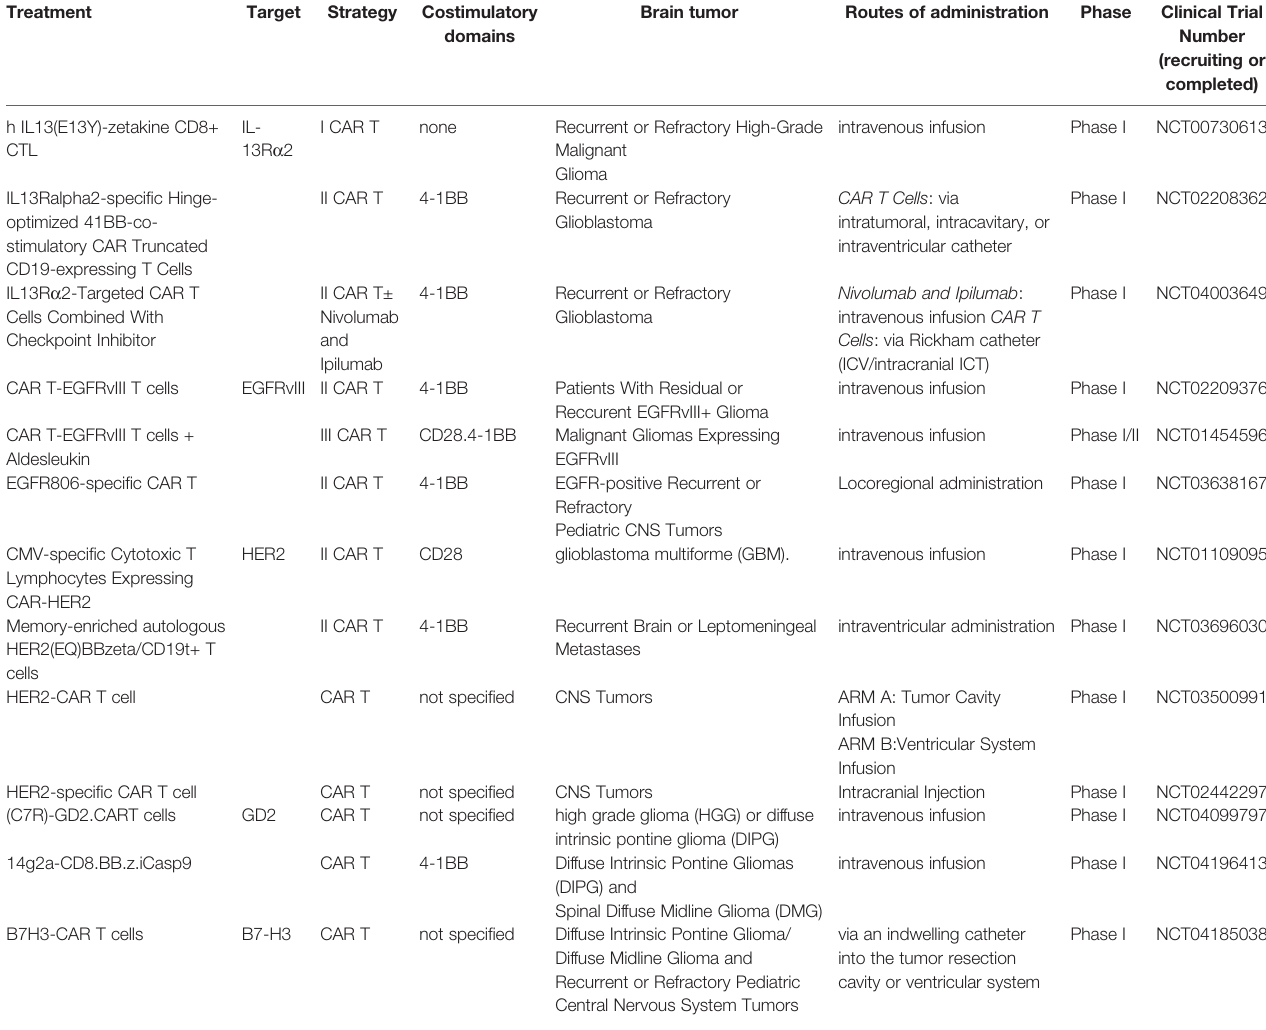
TABLE 2 | Summary of recruiting or completed clinical trials related to the use of CAR-T cells in the treatment of brain tumors.